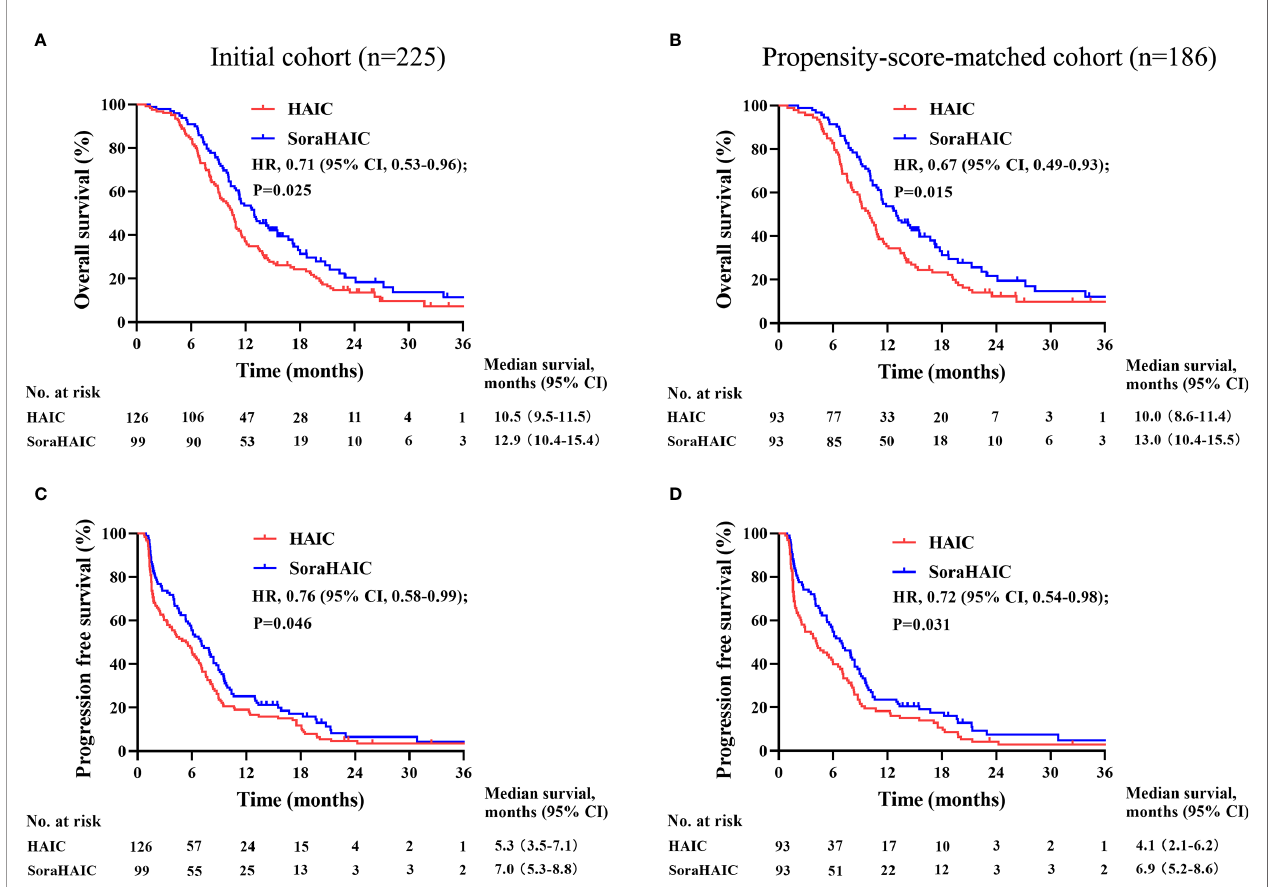
FIGURE 2 | Kaplan-Meier curves for overall survival (A) and progression-free survival (C) in the initial cohort and overall survival (B) and progression-free survival (D) in the propensity-score-matched